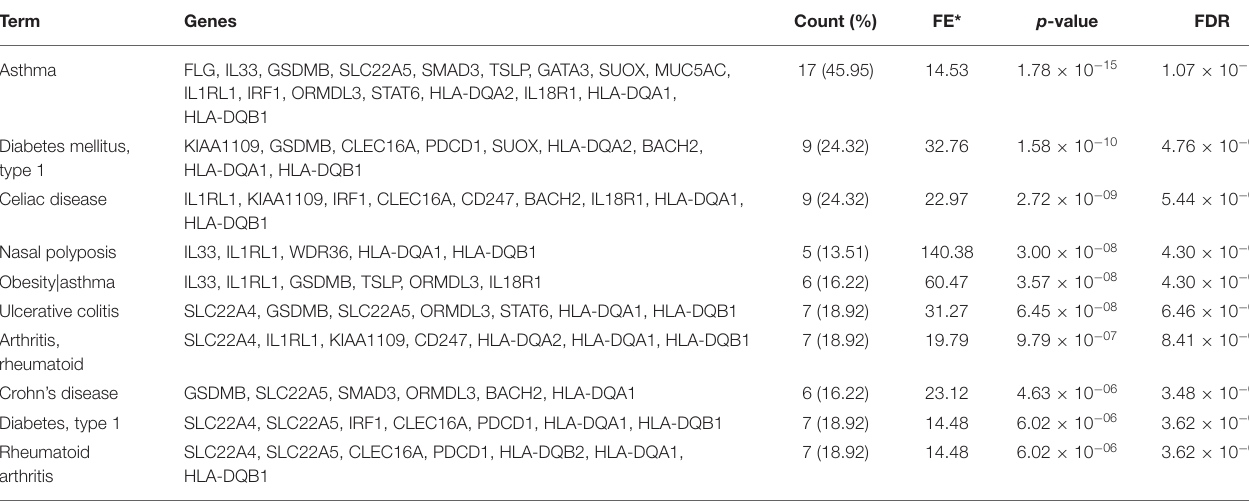
TABLE 6 | DAVID functional annotation tool analysis of the genetic association database of complex diseases and disorders (GAD). Term